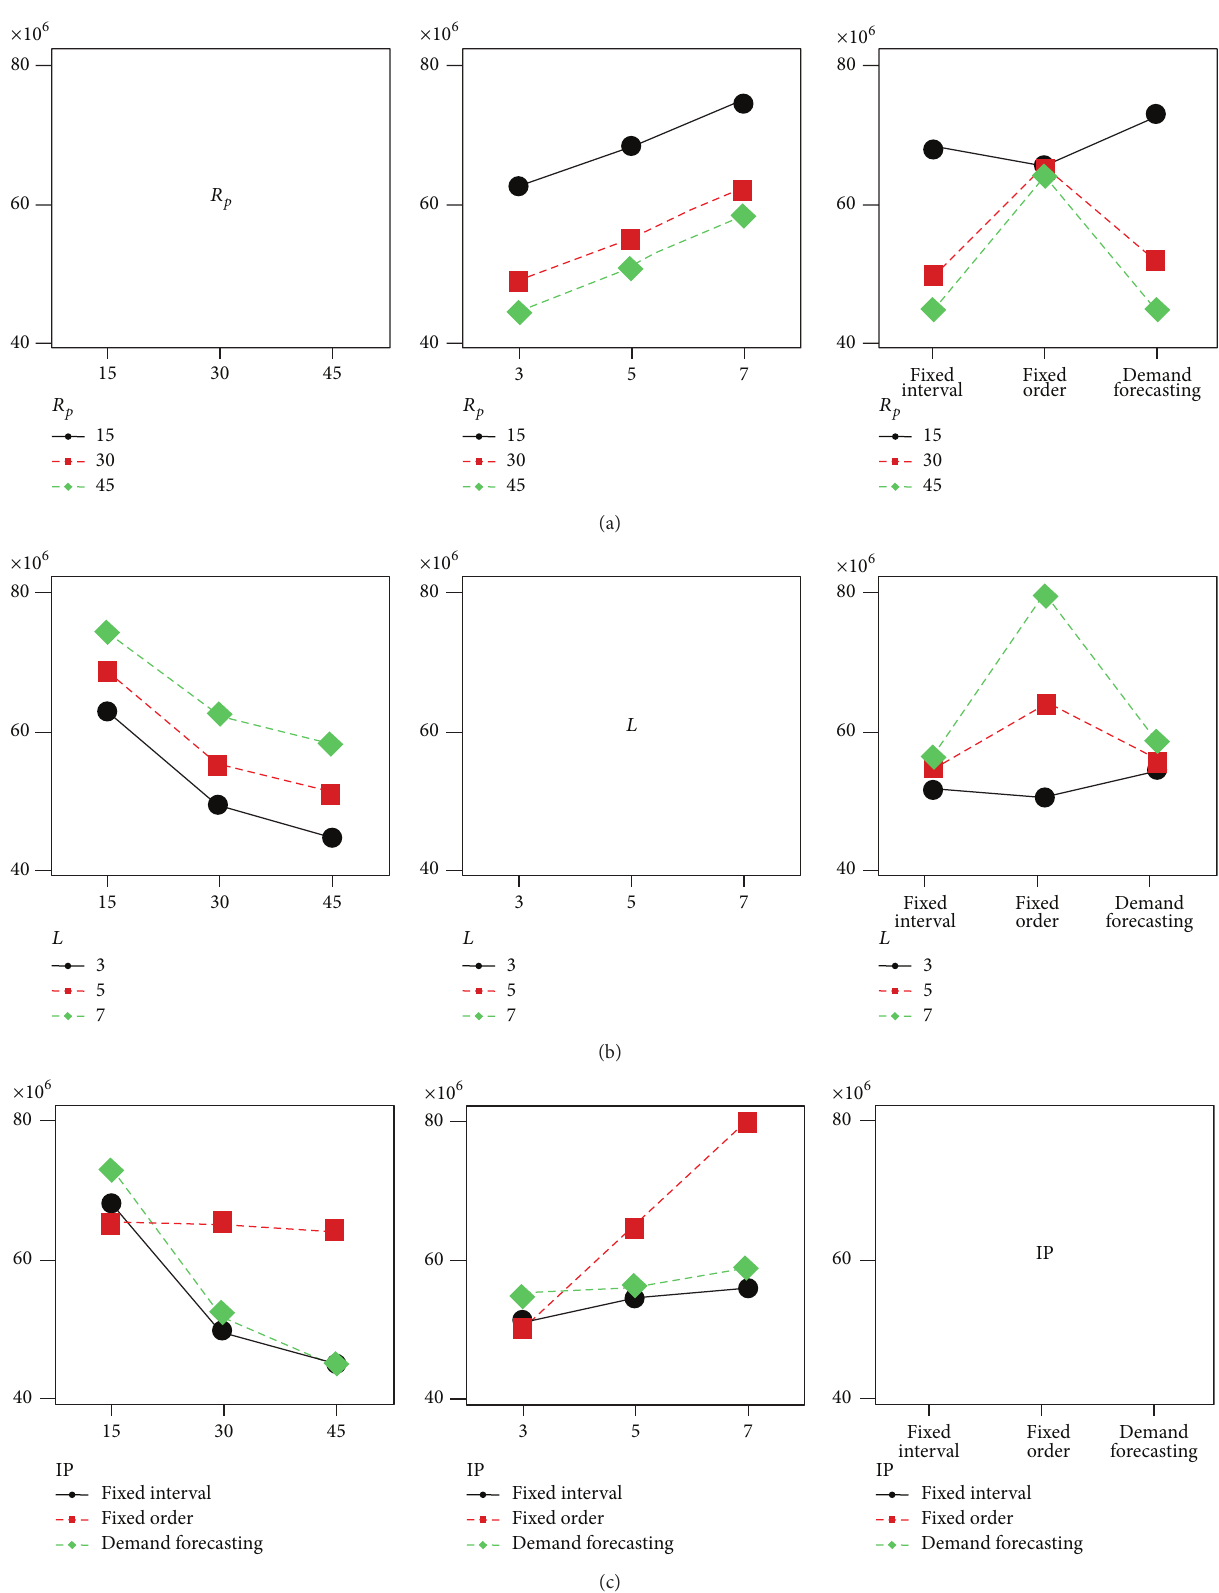
Figure 5: Interaction plot for product 𝐶 :